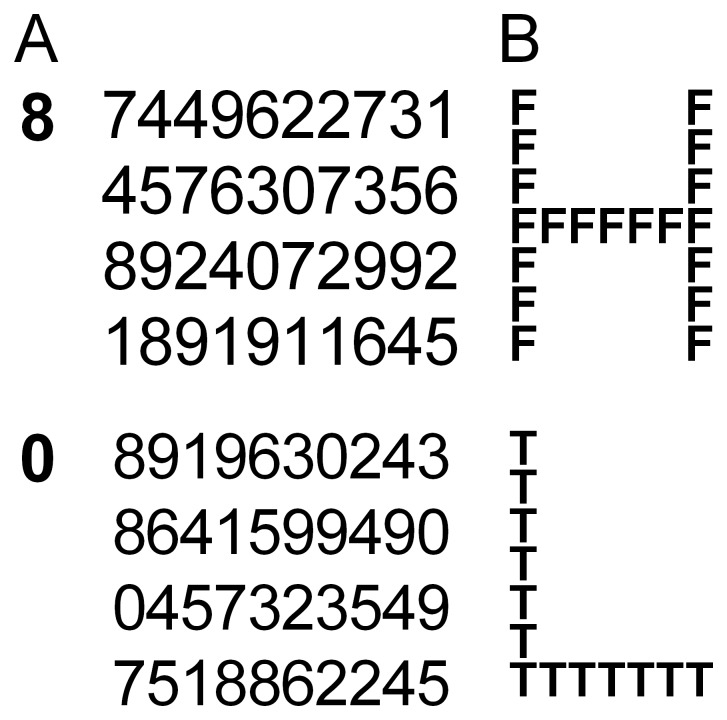
Examples of task stimuli used in Experiments 2 (A) and 3 (B).A: Participants searched a matrix for the designated digit shown on the left side of each matrix and to state the number of counts vocally. The answers are 2 (upper) and 3 (bottom). B: Participants indicated whether a stimulus contained the letter H or the letter T by pressing the left or right key on a response pad. The upper is a global target stimulus and the bottom is a local target stimulus.